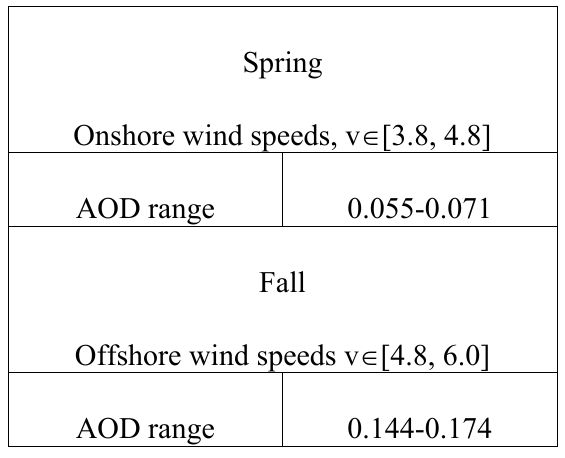
Table 7. The average ranges of AOD changes at RH=80% and for λ =550 nm in spring and fall calculated using the wind statistics for 1961-1990 and